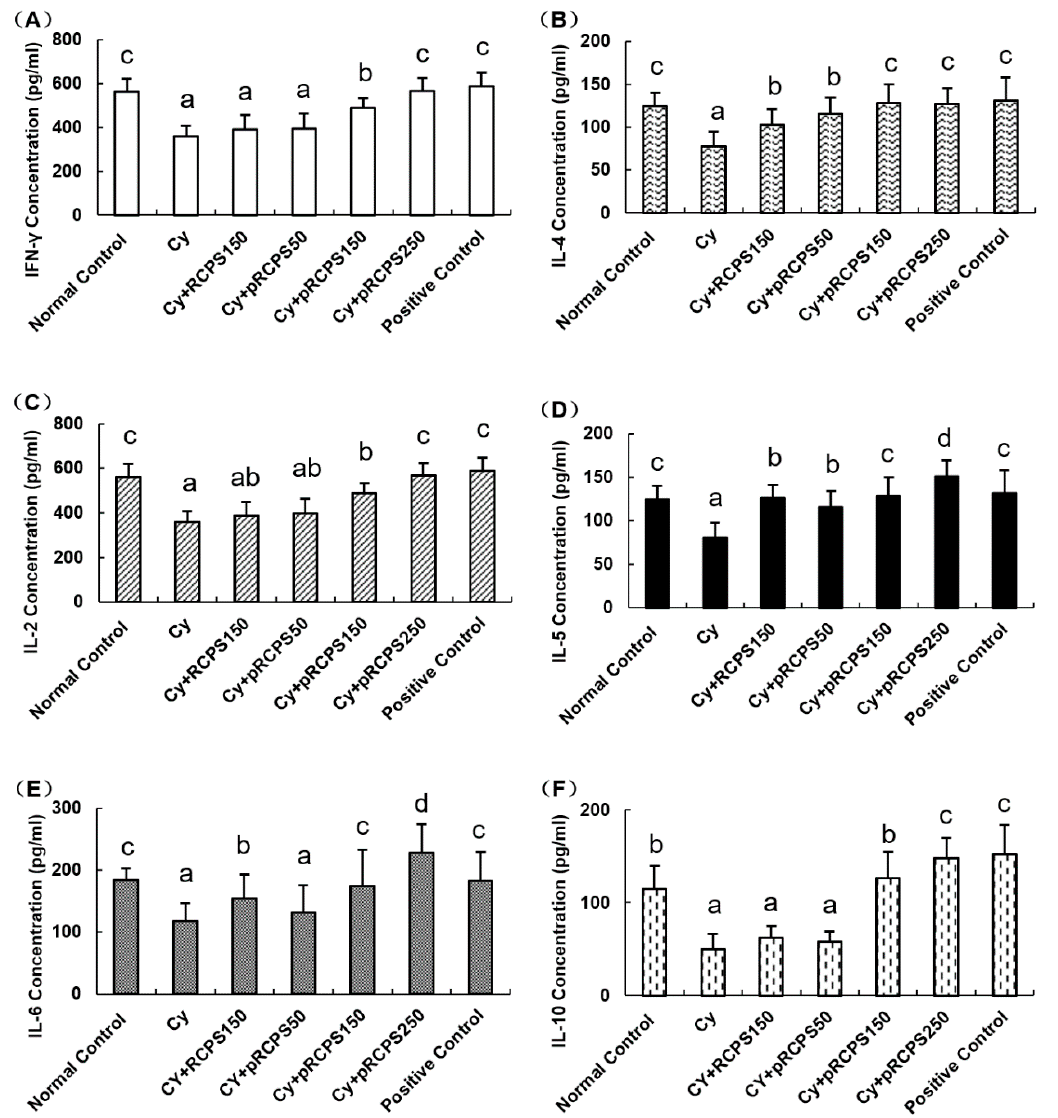
Figure 5. pRCPS effect on serum cytokines in immunosuppressed mice. After 24 h of the last treatment, serum samples were collected and the ( A ) IFN- γ , ( B ) IL-4, ( C ) IL-2, ( D ) IL-5, ( E ) IL-6, and ( F ) IL-10 were determined by ELISA. Results are presented as the mean ±SD ( n = 10). Bars marked with different letters (a–d) indicate differences that are statistically significant ( P < 0.05).